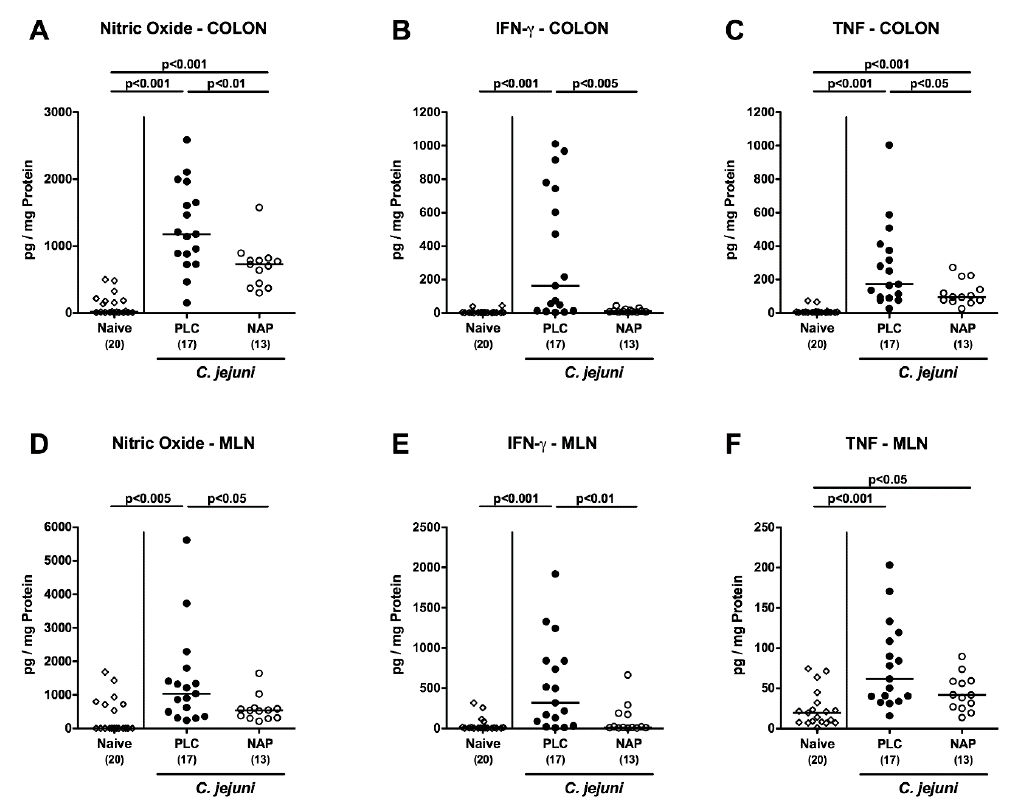
Figure 5. Intestinal pro-inflammatory mediator secretion following NAP treatment of C. jejuni infected secondary abiotic IL10 − / − mice. On day (d) 0 and d1 secondary abiotic IL10 − / − mice were perorally infected with C. jejuni strain 81–176 by gavage and treated intraperitoneally with either synthetic NAP (open circles) or placebo (PLC; closed circles) from d2 until d5. On d6 post-infection, nitric oxide ( A , D ), IFN- γ ( B , E ), and TNF ( C , F ) concentrations were measured in ex vivo biopsies taken from colon ( A – C ) and mesenteric lymph nodes (MLN; D – F ). Naive mice served as negative controls (open diamonds). Medians (black bars), levels of significance ( p -values) as determined by the Kruskal–Wallis test and Dunn’s post-correction, as well as numbers of analyzed mice (in parentheses) are indicated. Data were pooled from four independent